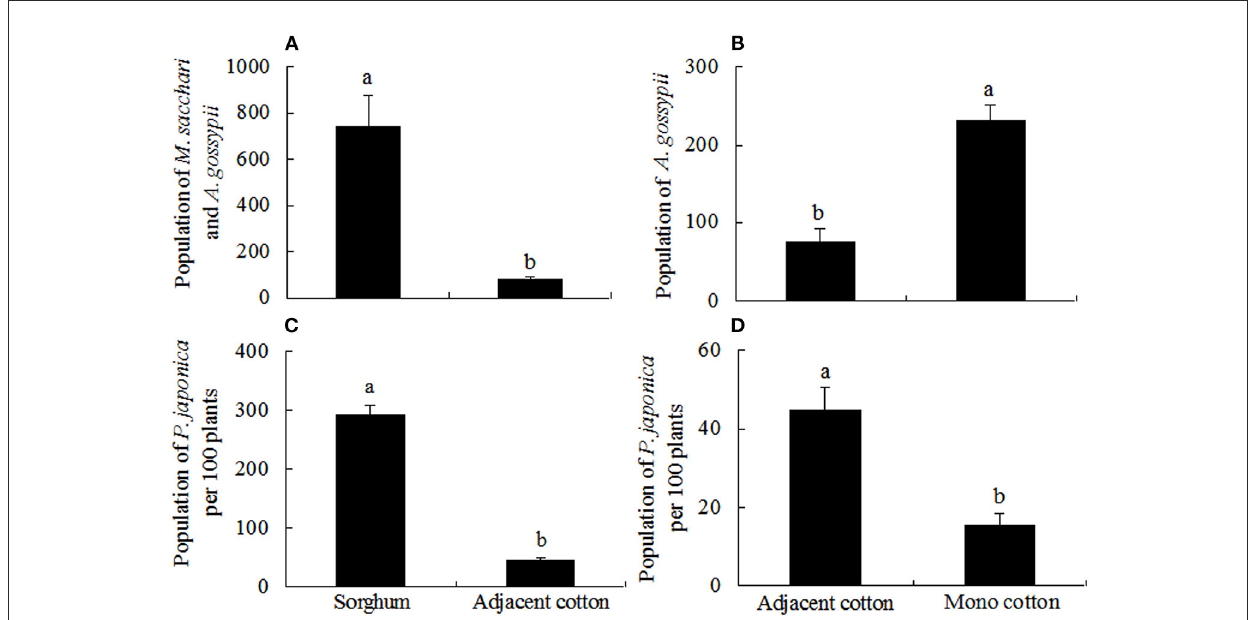
FIGURE1 Effect of adjacent crop management on the numbers of M. Sacchari , A. Gossypii and P. Japonica in the field. (A) Population of Melanaphis sacchari on sorghum and Aphis gossypii on adjacent cotton. (B) Population of A. gossypii on adjacent cotton and mono cotton. (C) Population of P. japonica per 100 plants of sorghum and adjacent cotton. (D) Population of P. japonica per 100 plants on adjacent cotton and mono cotton. Different lowercase letters indicate significant differences among different crops (Tukey’s test: P < 0.05).